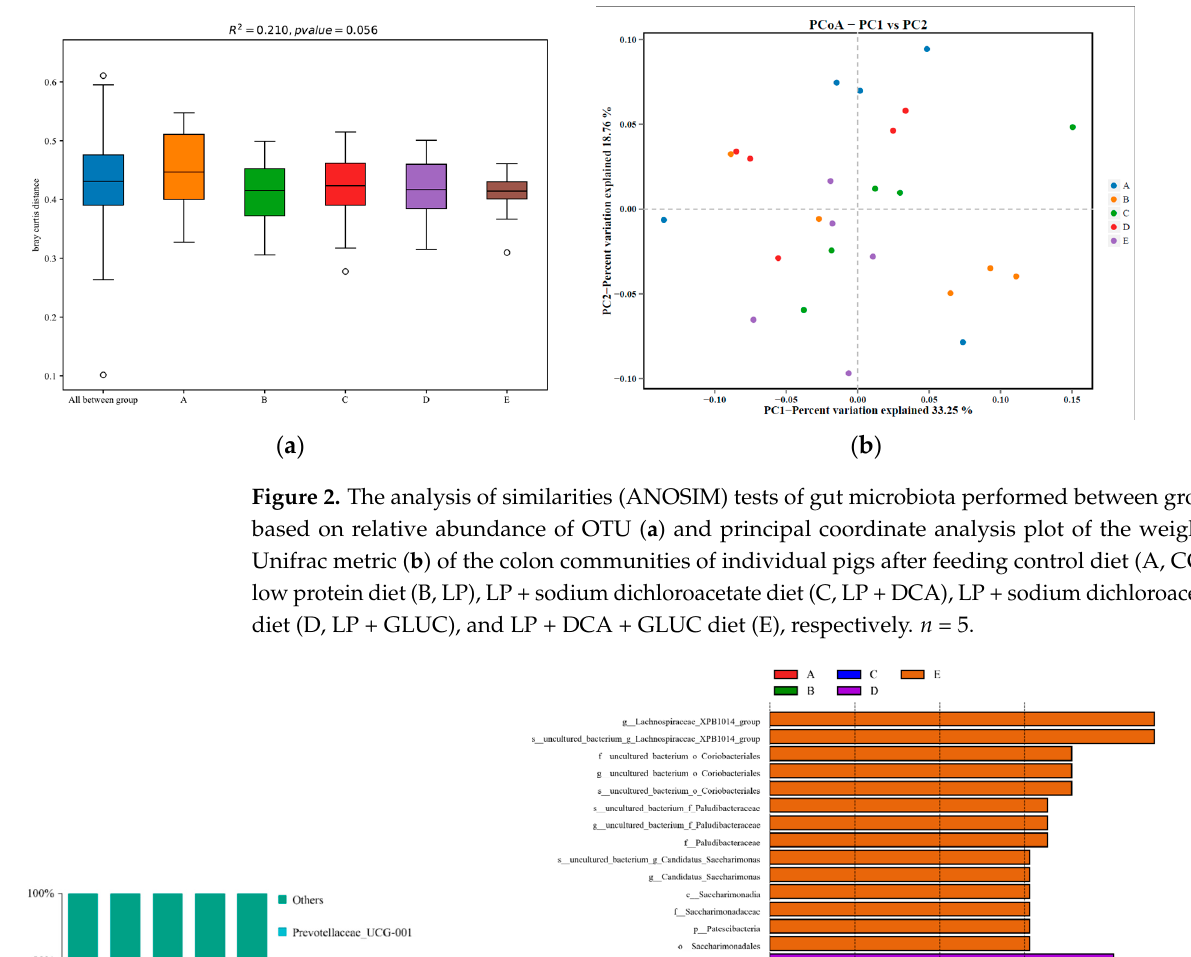
Figure 1. Alpha diversity including Chao1 ( a ), Ace ( b ), Shannon ( c ), and Simpson ( d ) of the colon communities of individual pigs after feeding control diet (A, CON), low protein diet (B, LP), LP + sodium dichloroacetate diet (C, LP + DCA), LP + sodium dichloroacetate diet (D, LP + GLUC), and LP + DCA + GLUC diet (E), respectively. n = 5.